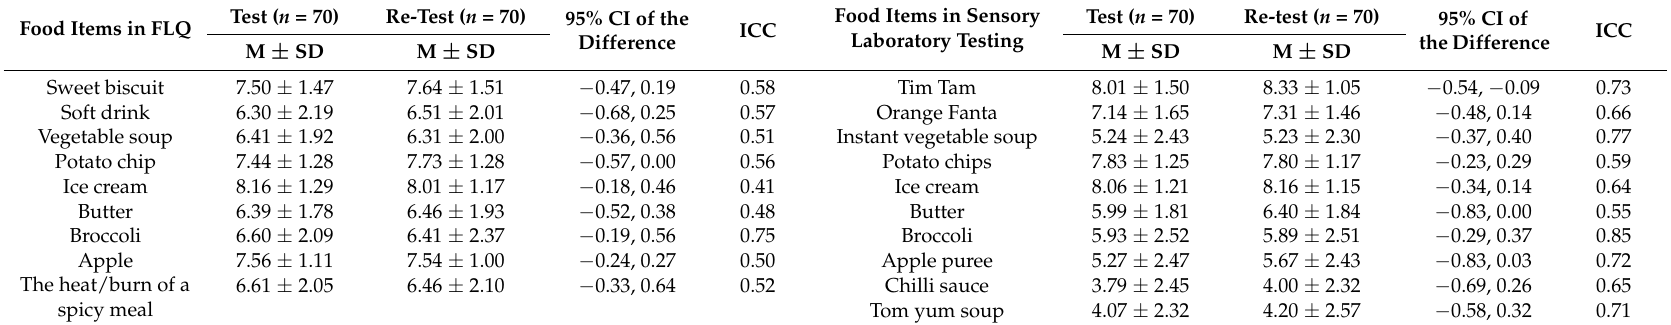
Table 3. Comparing mean score between test and re-test and reliability of Intra-Class Correlation Coefficients (ICC) of food liking questionnaire and laboratory-based liking assessment.